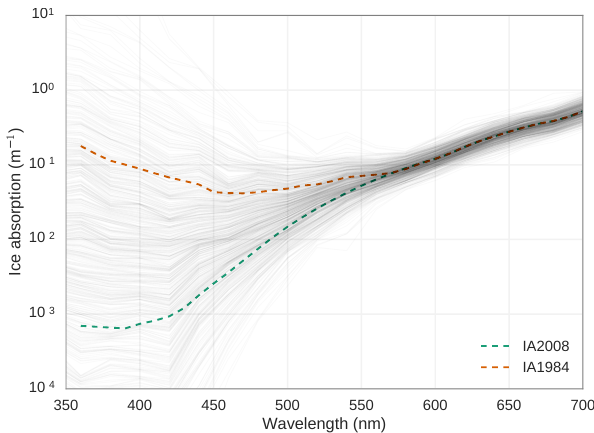
Figure 2. Samples (gray) of the prior distribution of the ice ab- sorption to be used by the BAY method. Ice absorption coefficients IA1984 and IA2008 are presented for